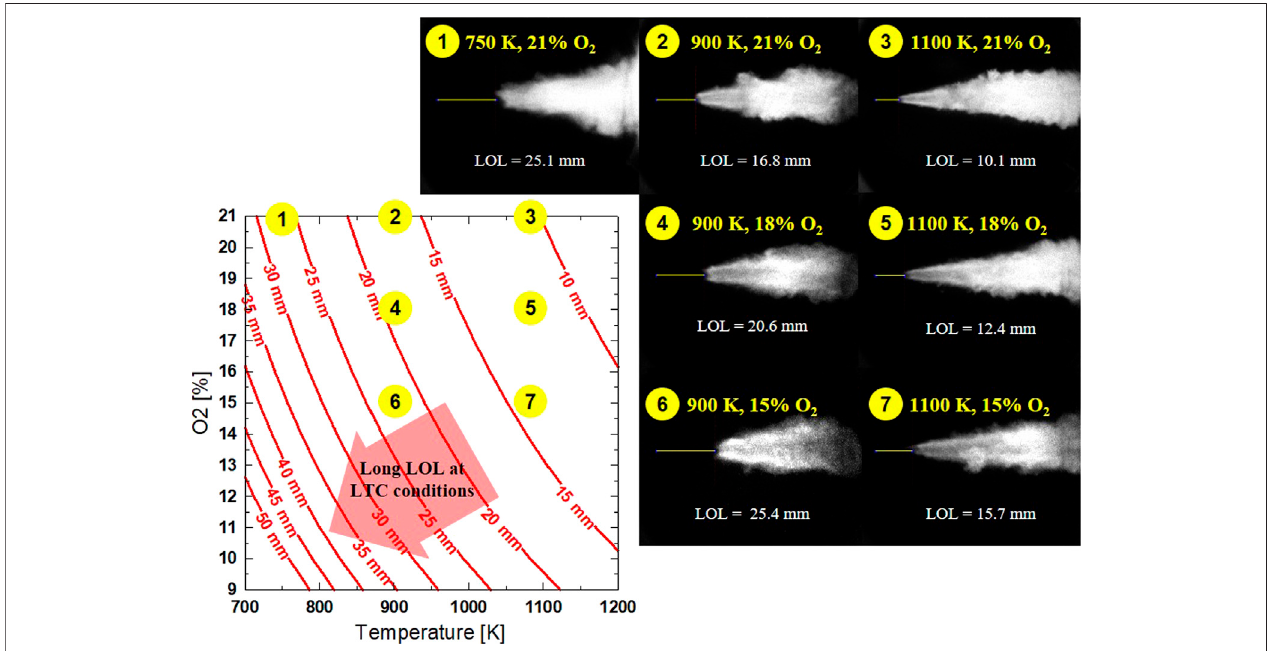
FIGURE 6 | Calculated LOL with different T amb and O 2 at similar P inj (cid:1) 75 MPa, ρ (cid:1) 14.8 kg/m 3 . Example OH* image shown for each corresponding (numbered) condition of T amb and O 2